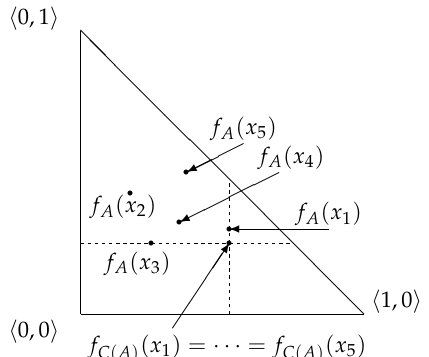
Figure 3. Geometrical interpretation of operator C